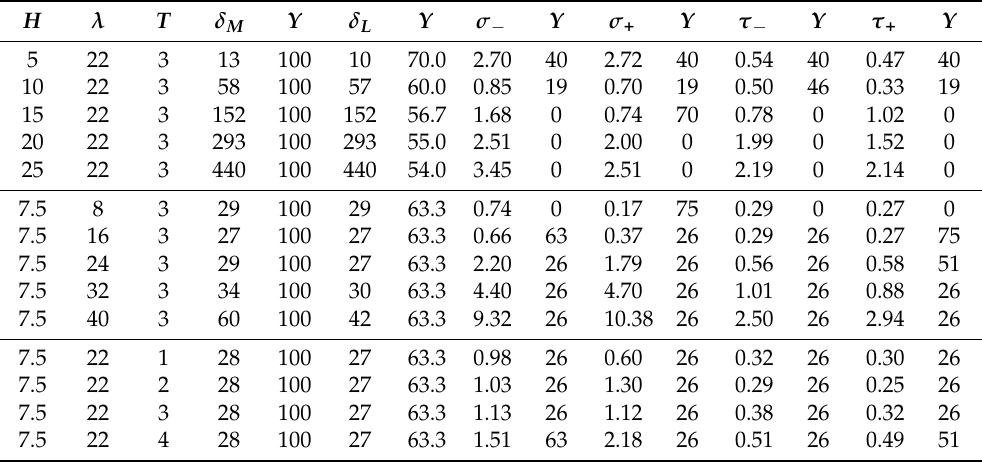
Table 4. Values and positions ( Y = %H from base to top) of maximum deflection ( δ M ) and deflection in the horizontal load ( δ L ) position (mm), maximum negative ( σ − ) and positive ( σ + ) normal stresses (MPa), and maximum negative ( σ − ) and positive ( σ + ) shear stresses (MPa) for the height ( H ), slenderness ( λ ), and taper (T × 102) values adopted in each of the simulated scenarios. Horizontal load 5 kN. H λ T δ